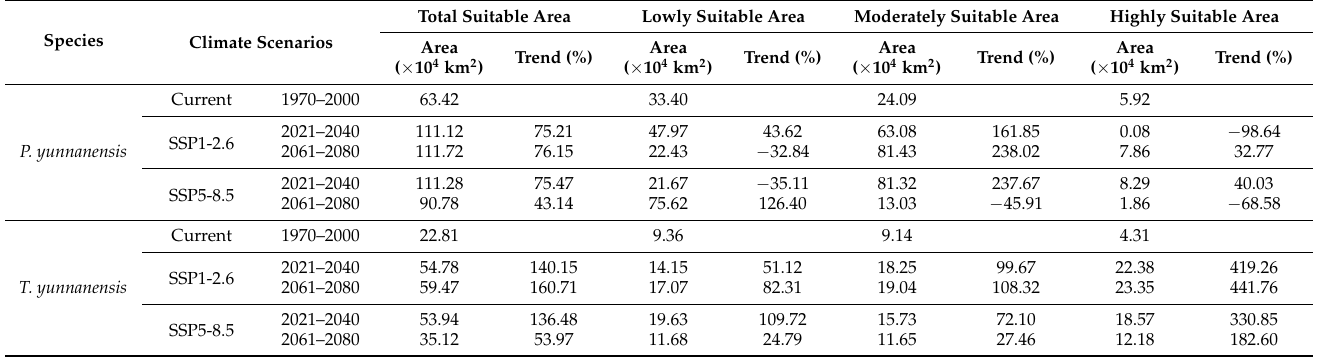
Table 2. Predicted suitable areas of P. yunnanensis and T. yunnanensis under different climate scenarios.